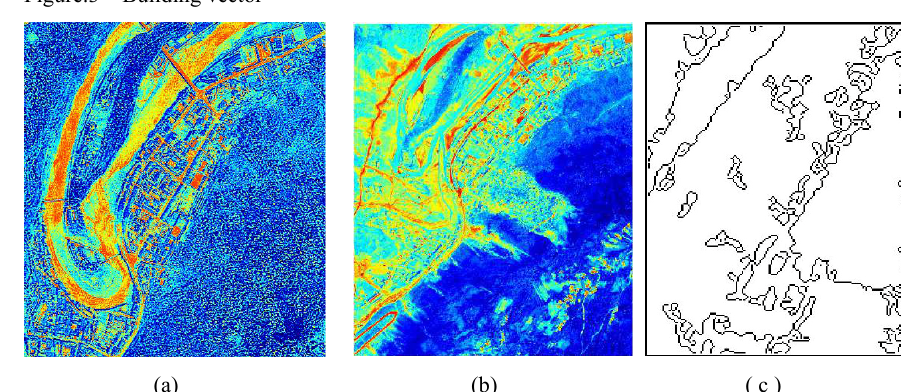
Figure.3 Building vector